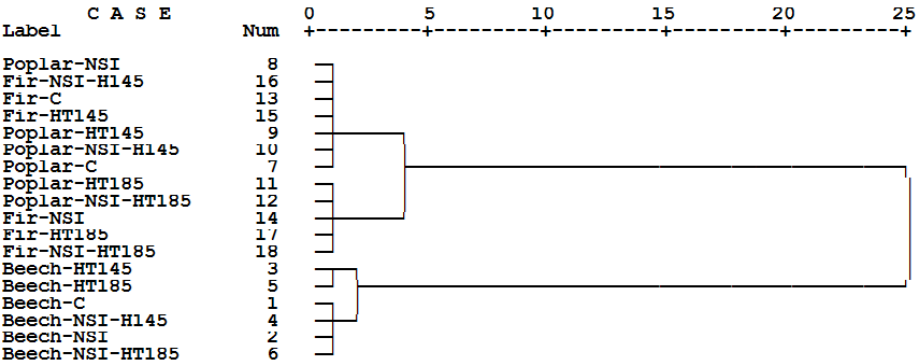
Figure 6. Cluster analysis of the three species (beech, poplar, and fir) based on the pull-off adhesion strengths of painted and unpainted specimens (C = control; HT = heat-treated at the specified temperature; NSI = nanosilver-impregnated specimens).